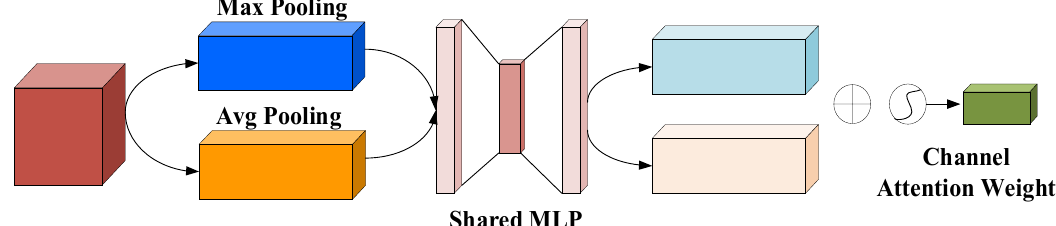
Figure 5. The channel attention module. The module uses both Max Pooling outputs and Avg Pooling outputs with a shared network.